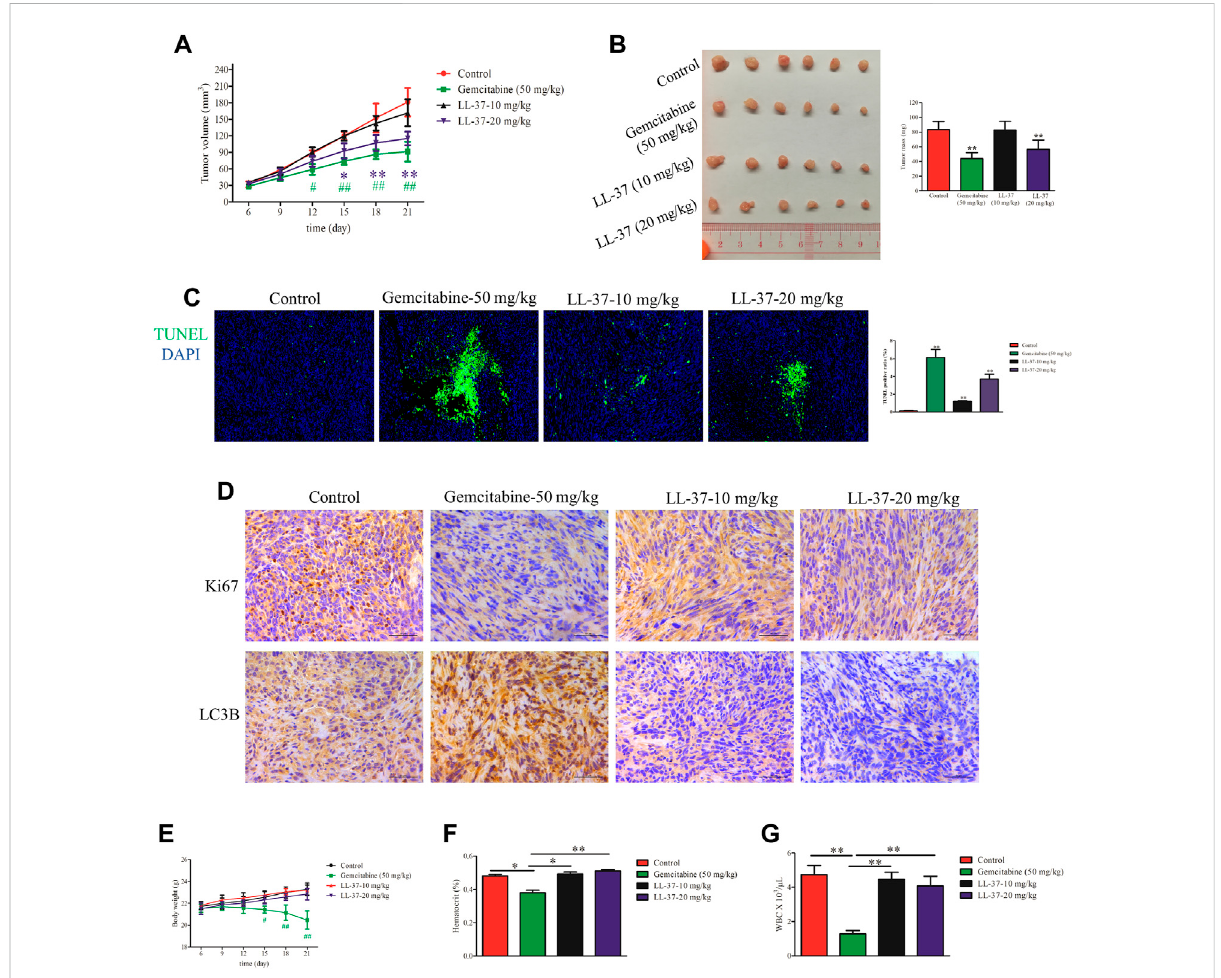
FIGURE 5 LL-37 inhibited the growth of pancreatic tumors in vivo . (A) The subcutaneous tumor diameters were measured every 3 days, and the tumor volumeswerecalculatedusingtheformula:(shortdiameter) 2 ×(longdiameter)×0.5.* p < 0.05,** p < 0.01forLL-3720 mg/kg vs. controlgroup; # p < 0.05, ## p < 0.01 for gemcitabine vs . control group. (B) The tumor weights in the control group, positive drug group (gemcitabine 50 mg/kg), low- dose LL-37 (10 mg/kg) group and high-dose LL-37 (20 mg/kg) group. ** p < 0.01 vs . control group. (C) Tumor tissues from mice in